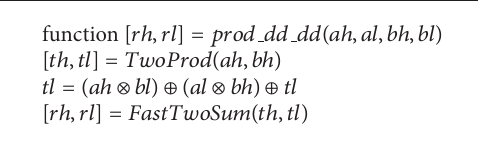
Algorithm 12: Multiplication of a double-double number by a double-double number.